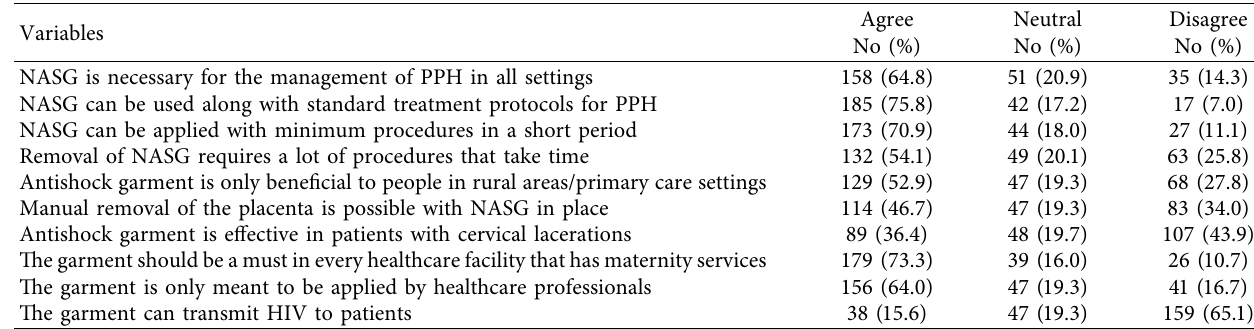
Figure 1: General knowledge of NASG for management of PPH among maternity ward health care professionals in selected South Wollo zone health facilities, North West Ethiopia, 2021. Table 3: Attitude toward NASG among maternity ward healthcare professionals in South Wollo Zone health facilities, Northwest Ethiopia,